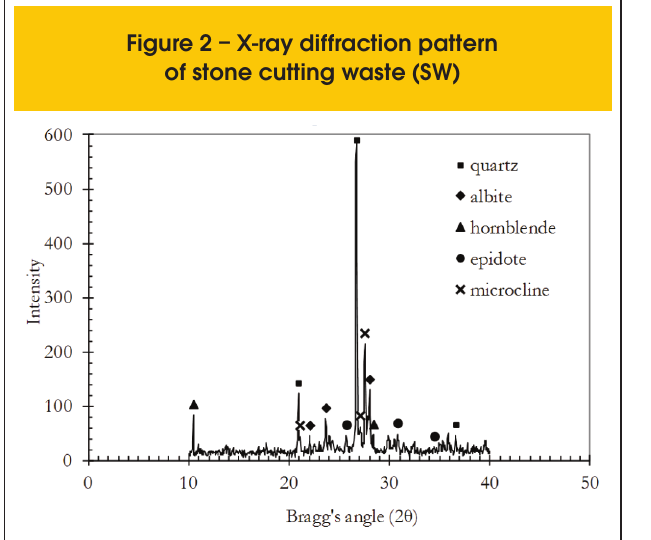
Figure 4 – TG/DTG curves of PC, SW and